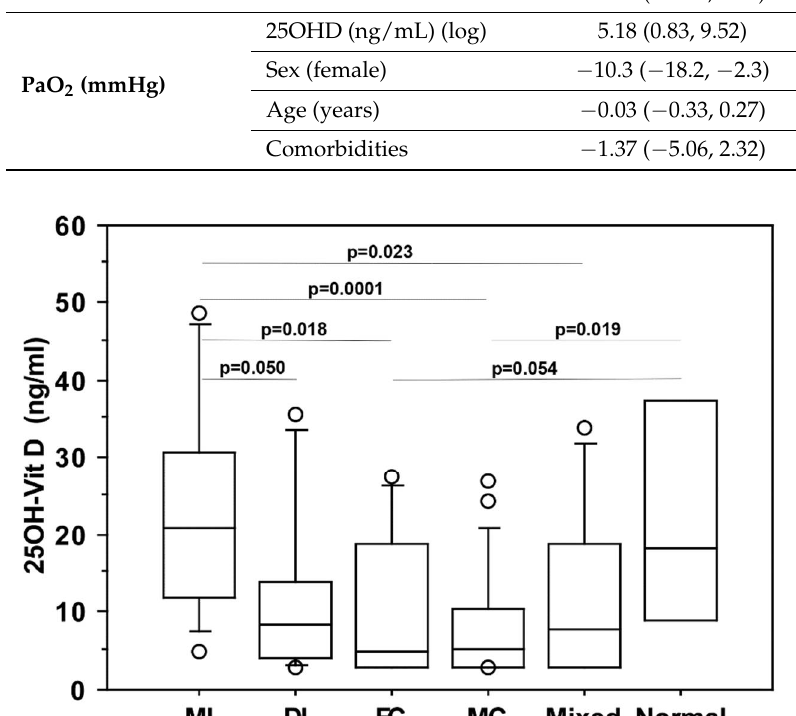
Figure 3. 25OH-vitamin D serum levels in COVID-19 patients with different radiological lung involvement. MI = localized/mild interstitial (11 patients), DI = diffuse/severe interstitial (8 patients), FC = focal consolidation (eight patients), MC = multiple consolidations (21 patients), Mixed = mixed abnormalities (13 patients), Normal = absence of radiological involvement (four patients). Data are given as 5th, 10th, 50th (median), 90th, and 95th percentiles. Only statistically significant differences between groups are reported.